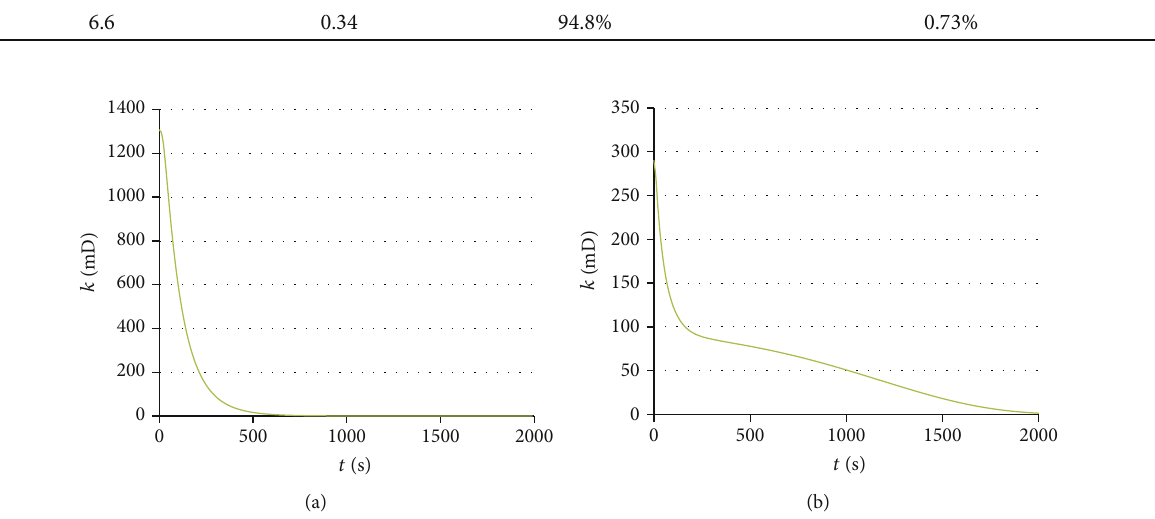
Figure 16: Variation curves of fracture permeability of coal samples with time. (a) Coal sample 1#. (b) Coal sample 2#.